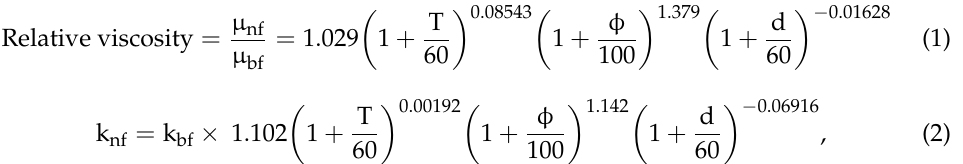
Figure 13. k enhancement comparison between the present study and the result of Maxwell et al. [76] and Pak et al. [75].